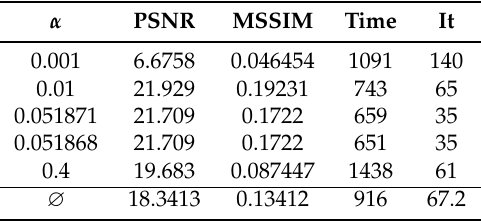
Table 4. Reconstruction of the cameraman-image corrupted by Gaussian blur and Gaussian white noise with σ = 0.1 for different regularization parameters α using the pdN with thresholded g